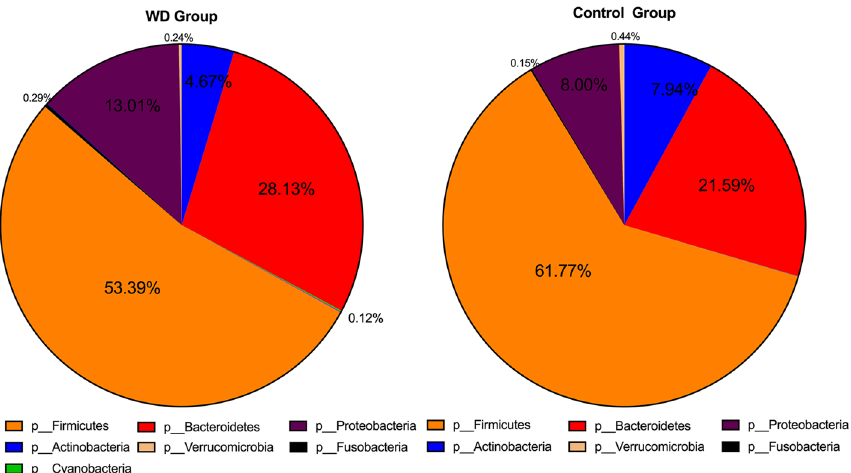
Figure. 2. In the taxonomic profile, the OTUs were assigned to prevalent microbiome components of Firmicute s (53.39% vs. 61.77%, P < 0.05), Bacteroidetes (28.13% vs. 21.59%, P < 0.05), Acidobacteria (4.67% vs. 7.94%, P < 0.05), Proteobacteria (13.01% vs. 8.00%, P < 0.05), Verrucomicrobia (0.24% vs. 0.44%, P < 0.05) and Fusobacteria (0.29% vs. 0.15%, P < 0.05) at the phylum level.